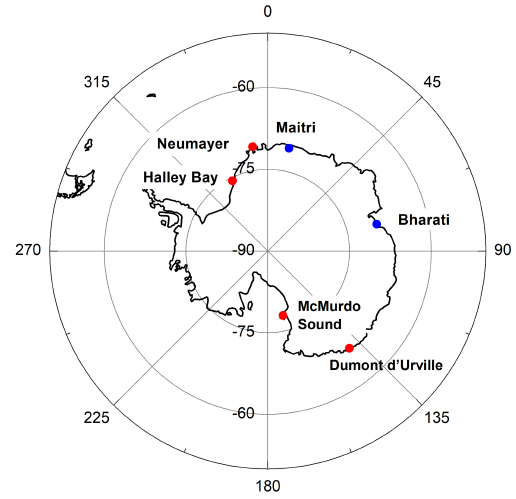
Figure 1. Map showing the location of the two Indian Antarctic sta- tions, Maitri and Bharati, where observations of IO were performed during this study (blue dots). Previous locations that have reported observations of IO (Frieß et al., 2001; Grilli et al., 2013; Hay, 2010; Saiz-Lopez et al., 2007a) are also marked on the map (red